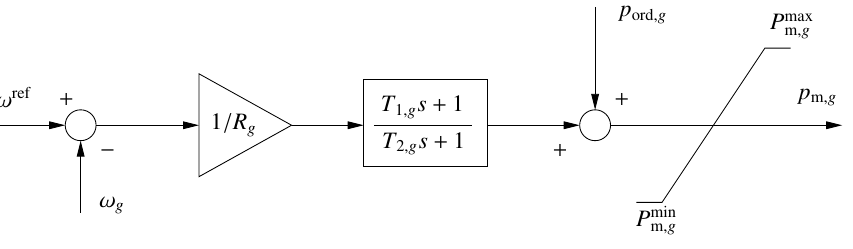
Figure 1. Standard turbine governor control